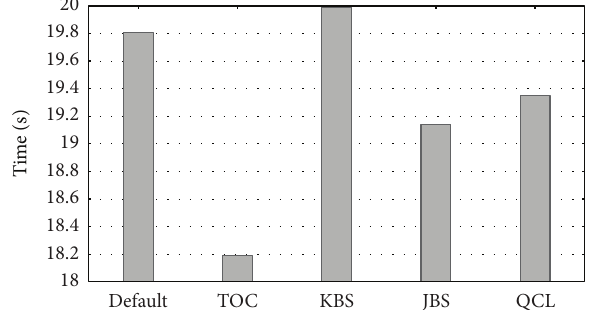
Figure 8: Runtimes for default and optimal values of the database server parameters. TOC: the table open cache , KBS: key buffer size , JBS: join buffer size, and QCL: query cache limit